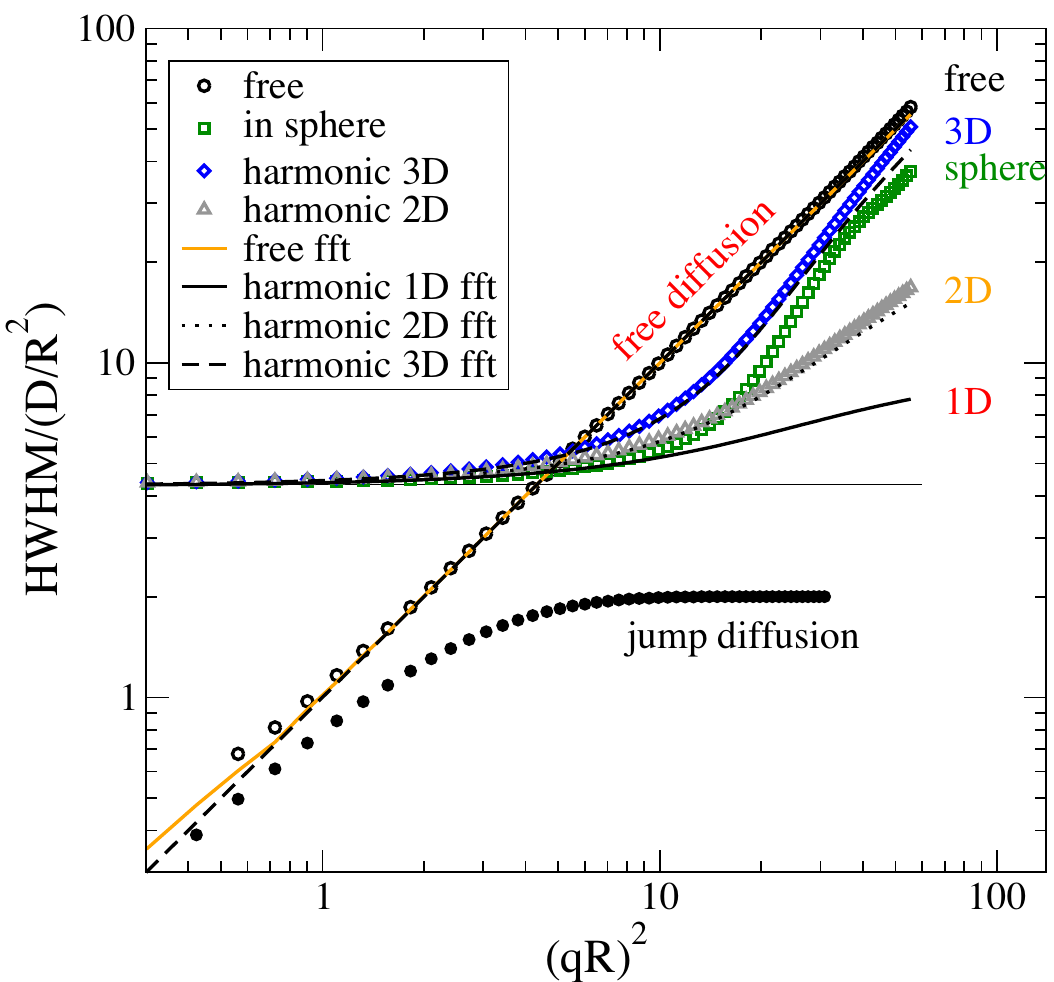
Fig 7. Half width half maximum (HWHM) determined from various dynamic models in comparison. Points show models in frequency domain as indicated. Data resulting from time domain models using Fourier transform are shown by lines. The plateau at low QR values demonstrates the effect from spatial restriction. At high Q a slope dependent on the dimensionality of the diffusion type is observed. The model for 1D diffusion in a frequency model is missing as the corresponding function in the reference seems to be wrong[58]. At very low QR determination of HWHM gets inaccurate. Calculated by Example 12 in